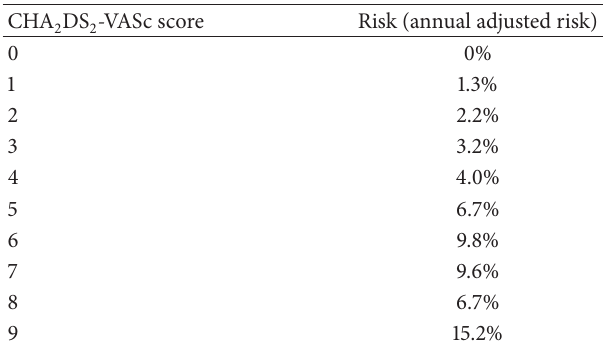
Table 2: Using the CHA score for stroke can be estimated and the benefits of anticoagulation